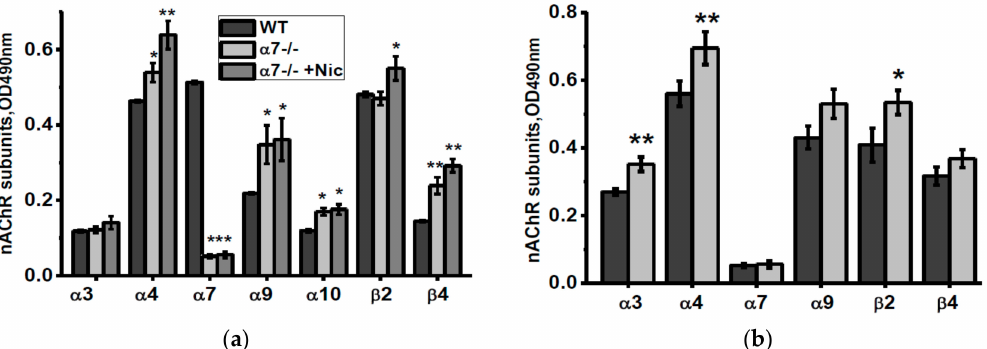
Figure 2. nAChR subunits composition in the brain (w / o mitochondria) fractions of α 7- / - mice under the e ff ect of either nicotine ( a ) or NSE ( b ). Each column corresponds to M ± SD, n-5. * p < 0.05; ** p < 0.005 compared to non-treated WT mice ( a ) or α 7- / - mice ( b ).